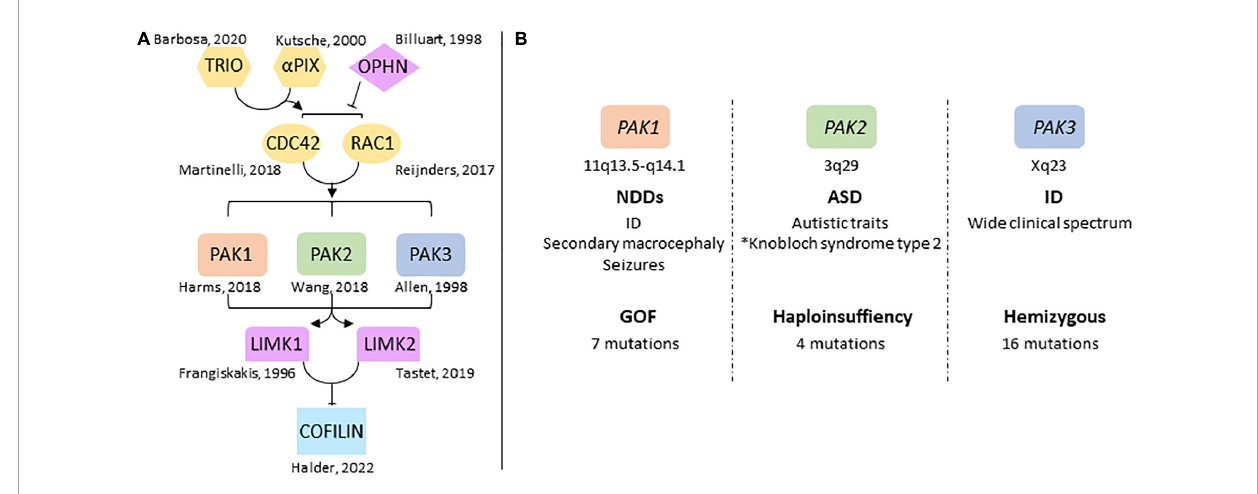
FIGURE1 Overview of group 1-PAKs in NDDs (A) genes of the RAC1/CDC42 pathway are involved in NDDs. The identification of pathogenic variations in several genes highlights the central role the dysregulation of this pathway plays in NDDs, notably via its control of actin cytoskeleton dynamics through cofilin. (B) Chromosomal location of PAK genes and conditions generally associated with PAK variations. PAKs are associated with very different mutational and clinical landscapes. *Antonarakis et al.